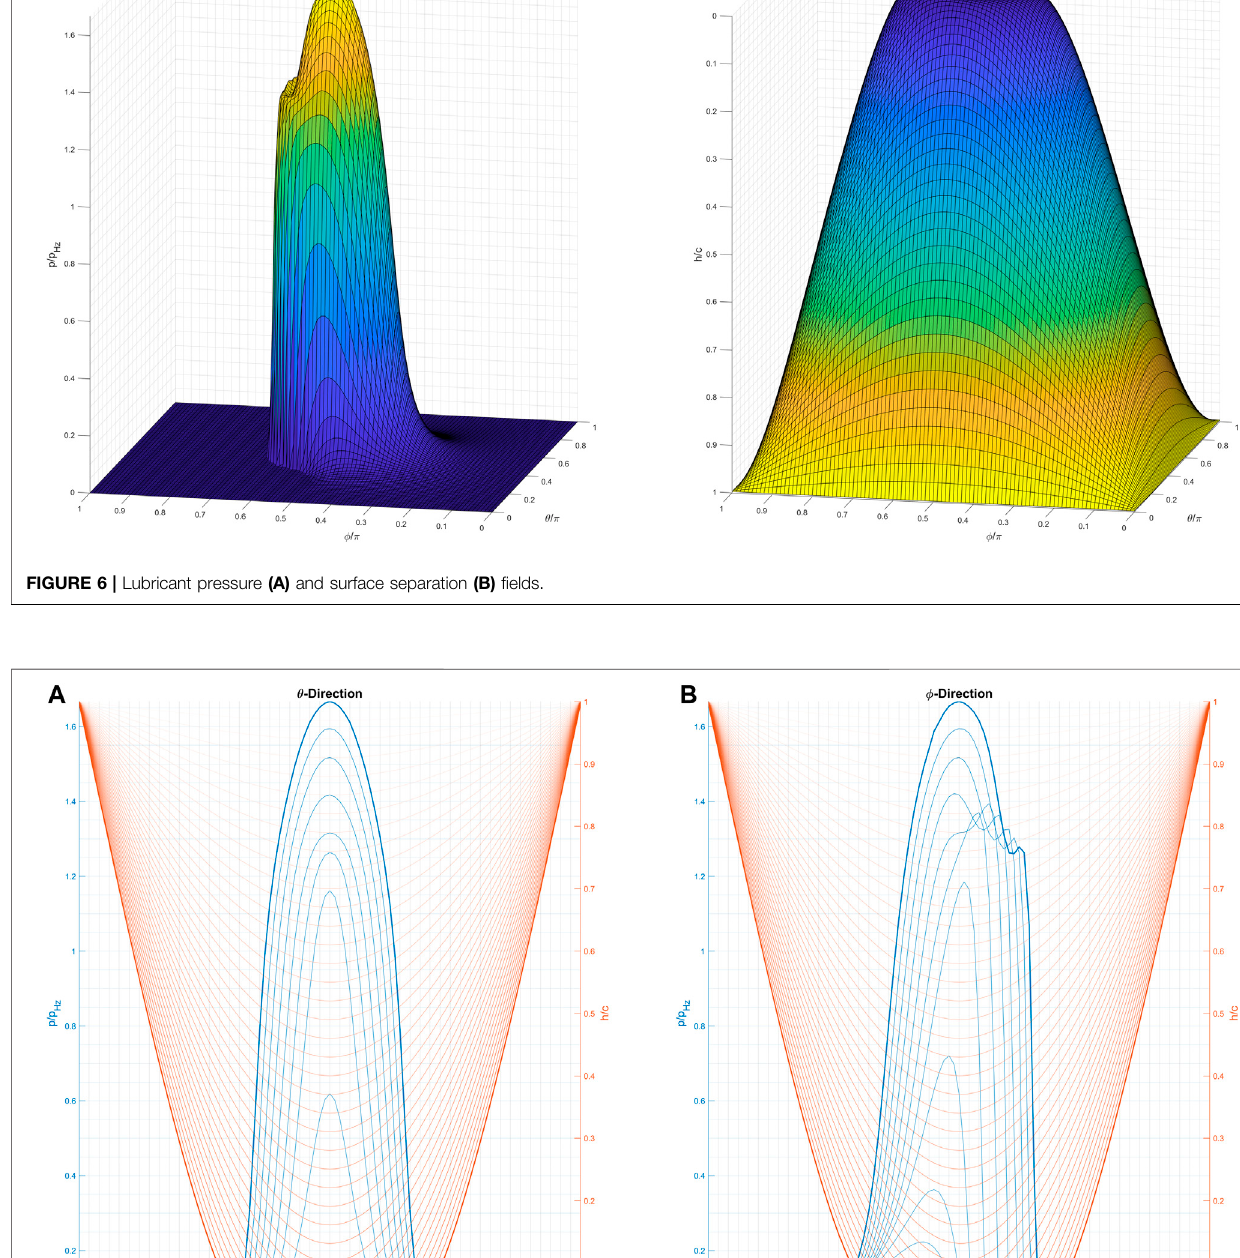
Frontiers in Mechanical Engineering |